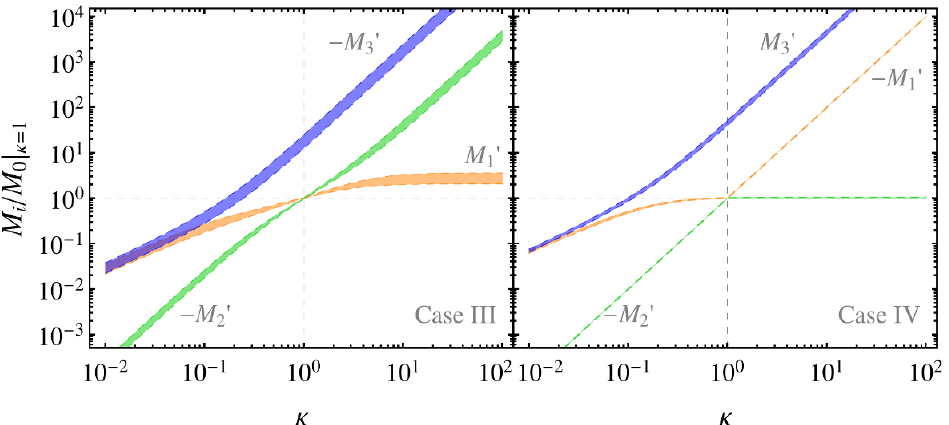
Figure 5 . Mass spectrum for IO solutions (cases III and IV) relative to the lightest mass M 0 for (cid:20) = 1, for N 1 (orange), N 2 (green) and N 3 (blue), as a function of (cid:20) . We use the 3- (cid:27) ranges in ref. [56] for the observables not (cid:12)xed by symmetry. M 0 their CP